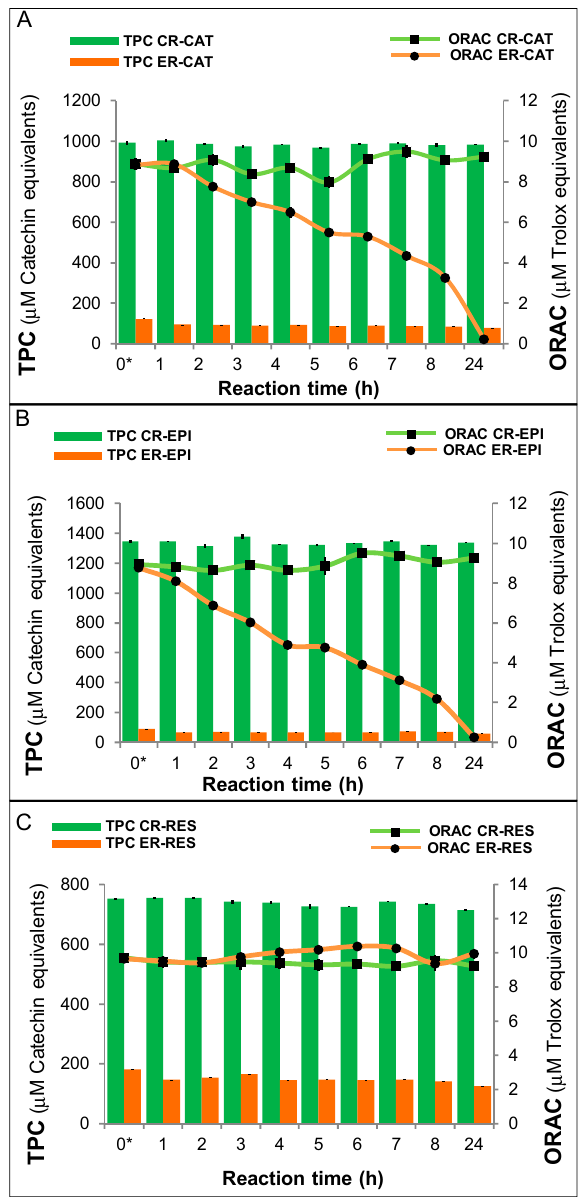
Figure 3. Relationship of the antioxidant capacity, determined by the oxygen radical absorbing capacity (ORAC) method, and the total phenolic content (TPC) in the reaction with ( A ) catechin (CAT), ( B ) epicatechin (EPI), and ( C ) resveratrol (RES) evaluated at different reaction times. Values are mean ± SEM, n = 3. Concentrations of phenolic compounds (PCs), peroxidase, and hydrogen peroxide (H 2 O 2 ) in the reaction medium of the enzymatic reaction (ER) were 1.5 mM, 2.5 U/mL, and 0.05%, respectively. In the control reaction (CR), peroxidase was substituted by phosphate buffer solution.